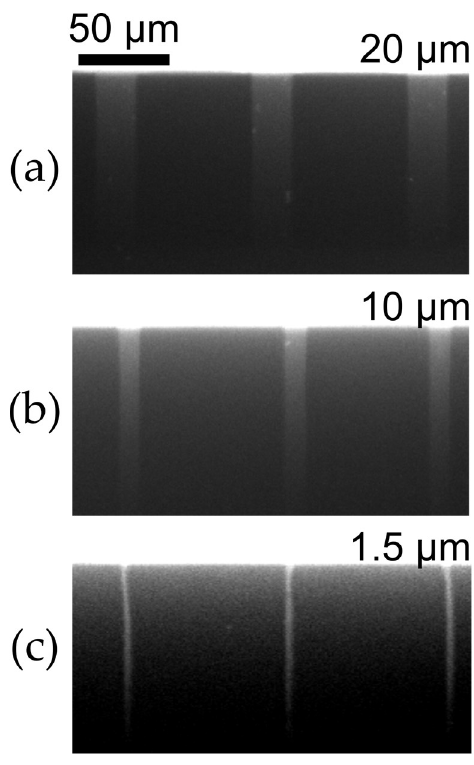
Figure A1. Representative images of FITC-conjugated dextran diffusion profile across microchannels of different widths at the 4 h time point. ( a ) 20 µ m width microchannels. ( b ) 10 µ m width microchannels. ( c ) 1.5 µ m width microchannels.